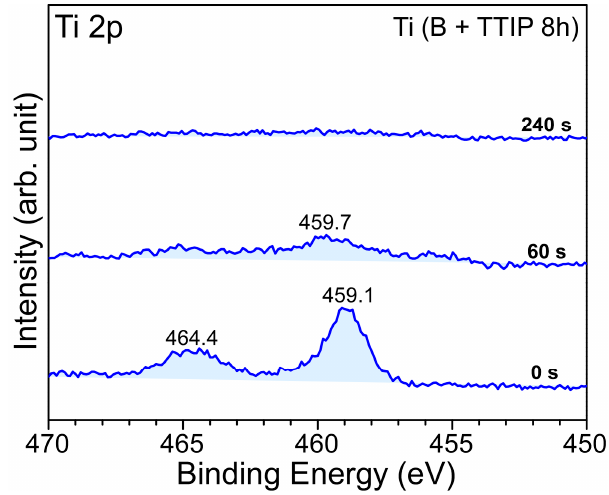
Figure 6. Variation in the Ti 2p XPS spectra with increasing sputtering time for the 8 h wet-milled boron sample.